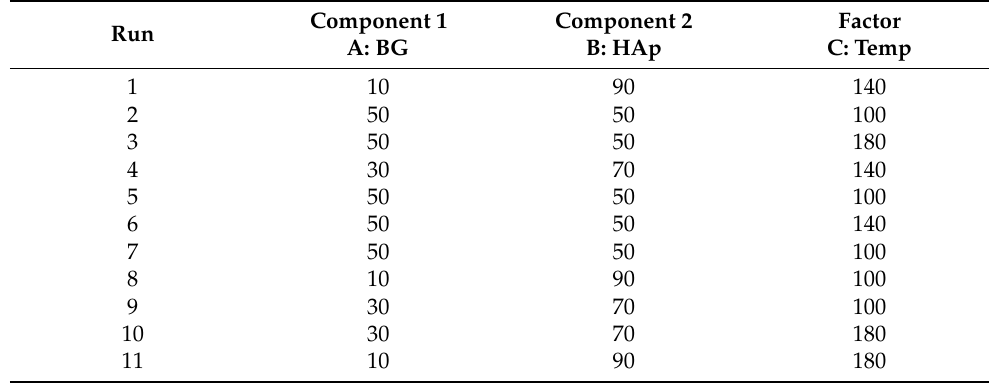
Table 3. Combined design and component